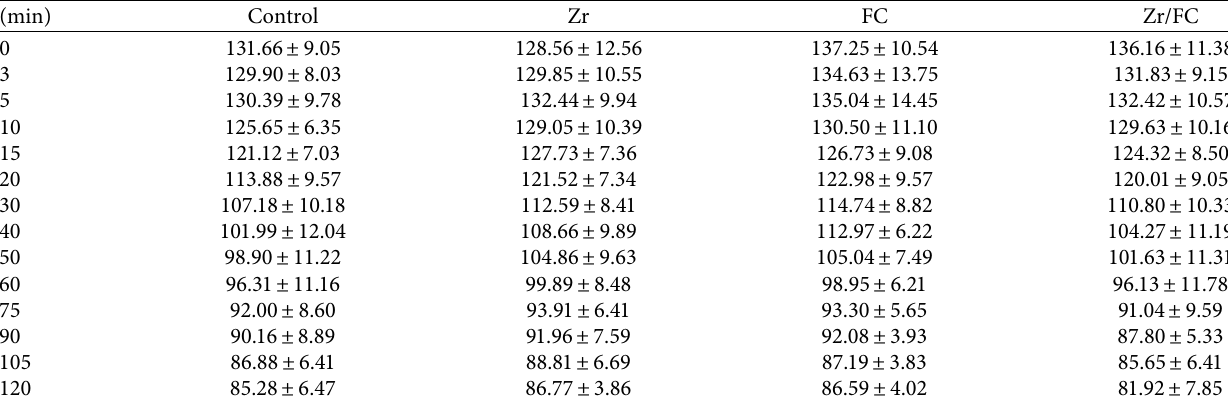
Control: specimenswith no surface treatment, Zr: plasma exposureon zirconia, FC: plasma exposureon feldspathic ceramic, Zr/FC: plasma exposureon both zirconia and feldspathic ceramic.